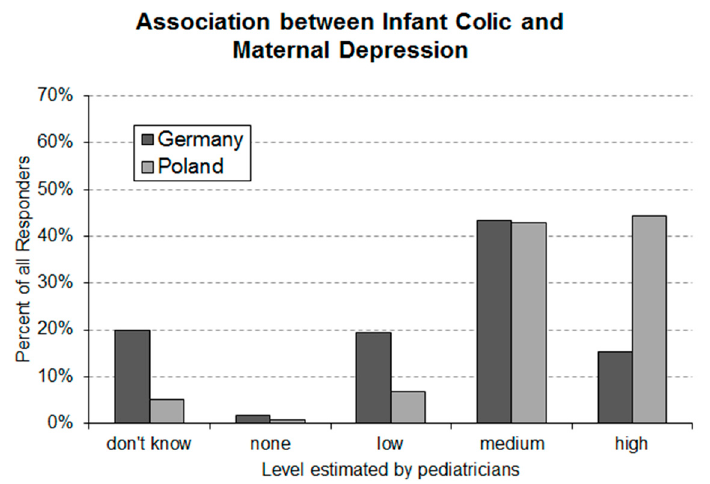
Figure 3. Level of association between infantile colic and maternal depression estimated by German ( n = 160) and Polish ( n = 133) pediatricians. The asymptotic Linear-by-Linear Association Test revealed a highly significant ( p -value = 2.064 × 10 − 7 ) between-country difference.